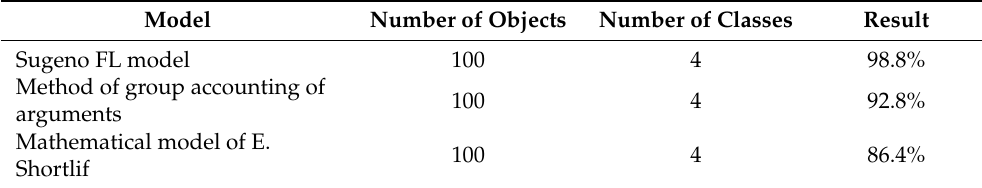
Table 1. Sugeno FL model and comparative results with the method of group accounting of arguments and the mathematical model of E. Shortleaf.